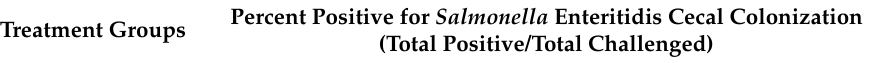
Table 1. Number of chickens positive for Salmonella Enteritidis ceca colonization for 2 weeks following challenge.